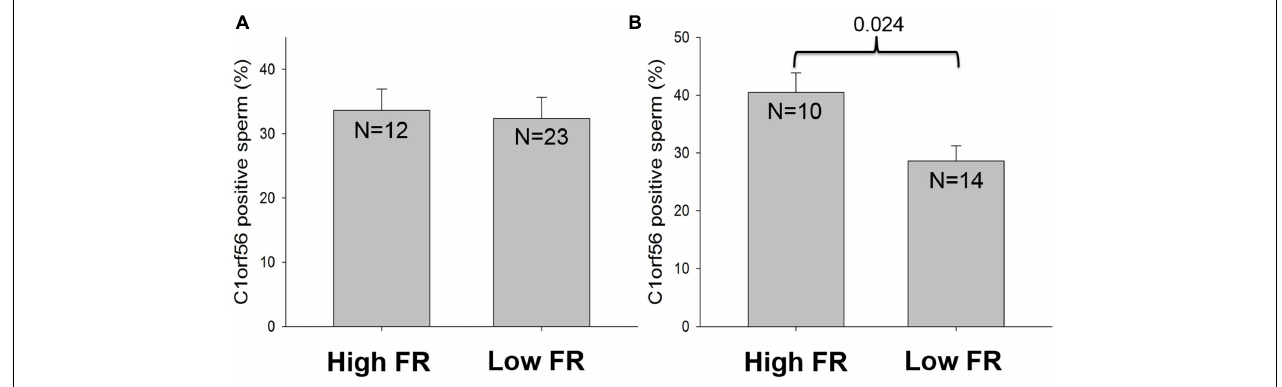
FIGURE 7 | The relationship between C1orf56 expression and fertilization rate. C1orf56 surface expression is determined on (A) capacitated spermatozoa and (B ) acrosome reacted spermatozoa by flow cytometry. Data was classified and analyzed according to the fertilization rate (FR), which is divided into high FR group ( FR ≥ 60%) and low FR group ( FR <